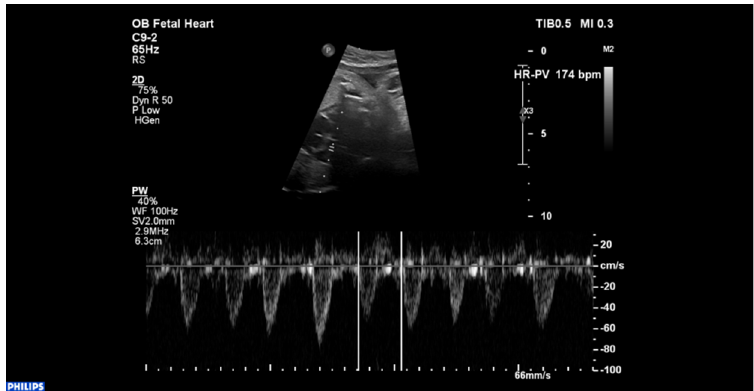
Figure 1. Fetal echocardiogram displaying couplets of premature ventricular beats. During evolution, due to a decrease in contractile function, quantified by left ventric- ular ejection fraction and global longitudinal strain (Figure 2), as well as the appearance of pericardial effusion, the decision to initiate antiarrhythmic medication with sotalol was made.